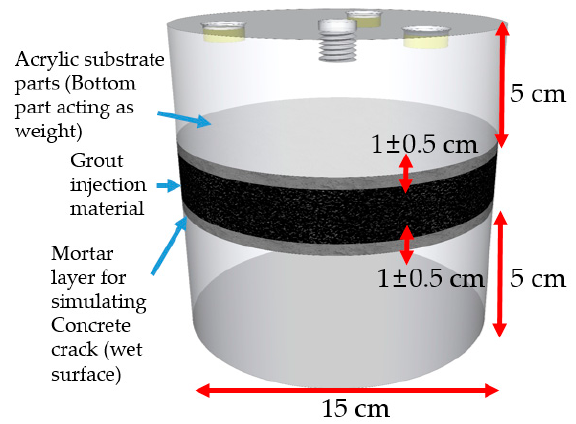
Figure 6. The specimen for wet surface adhesion strength testing.